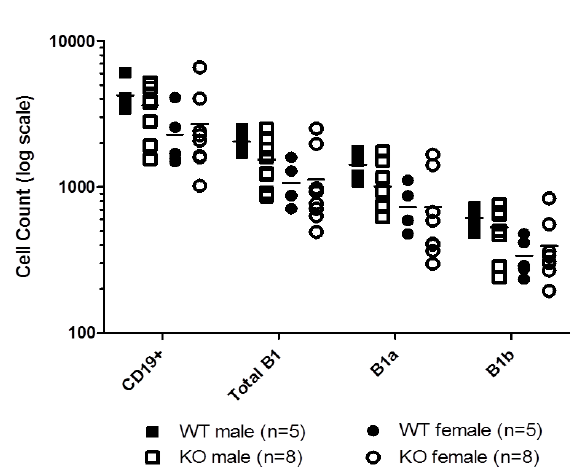
Raw flow cytometry sample data and the FlowJo analysis file for ex vivo stimulated splenocytes, including cell proliferation and